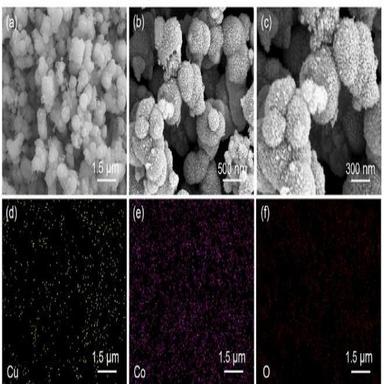
(a–c) SEM images of CuCo2O4/CuO microspheres along with the elemental mappings of (d) Cu, (e) Co, and (f) O. The mapping images were taken from the same position in (a).